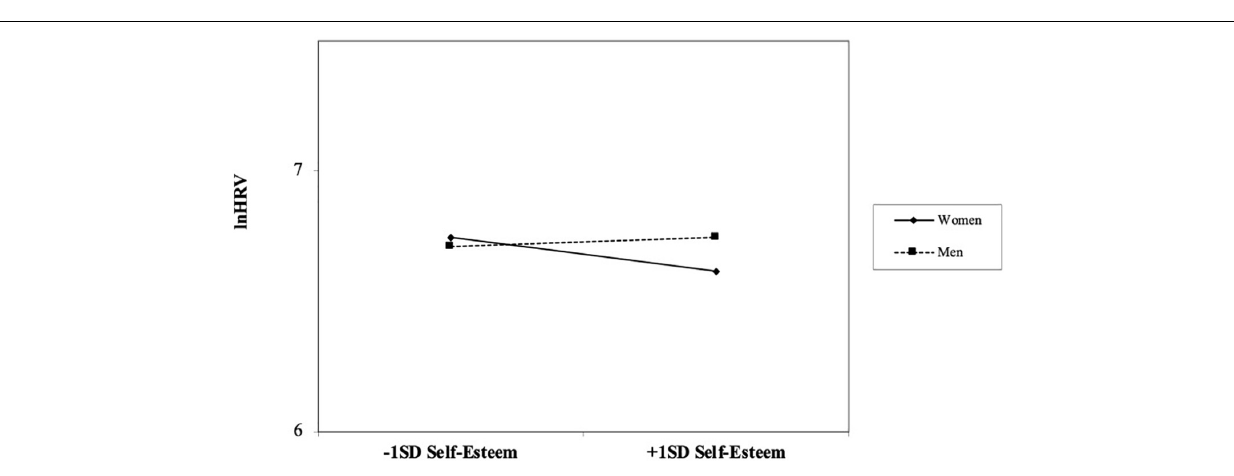
FIGURE 3 | Interaction of self-esteem and sex on heart rate variability